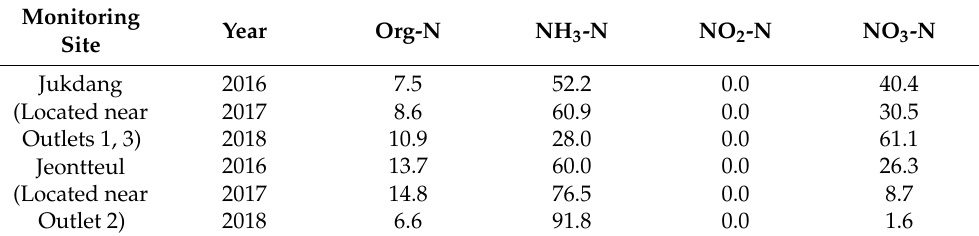
Table 6. Monitoring results of nitrogen in the Jukdang and Jeontteul rivers (%).